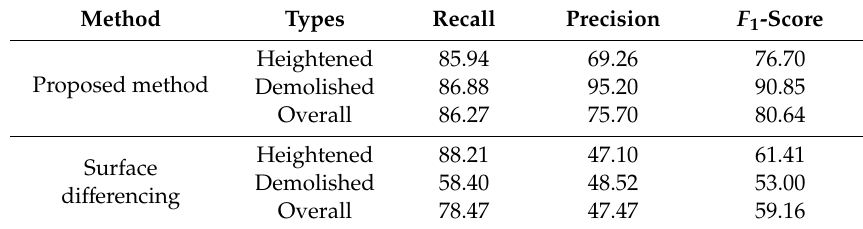
Table 3. Pixel-based change detection results of Rotterdam data (%).